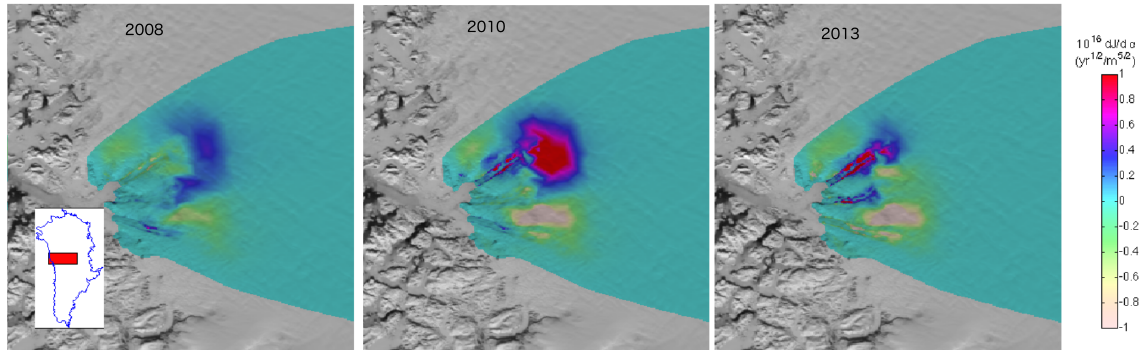
Figure 4. Gradient of the surface velocity cost function (spatio-temporal average of the misfit between a 5-year time series of observed surface velocities and the modeled surface velocity) with respect to the basal drag coefficient (in yr 1 / 2 m − 5 / 2 ). The gradient is computed for every time step of a 2-week interval time series between 2008 and 2013. We only show three periods (2008, 2010, and 2013) in the entire interval. The location for the study is Upernavik Glacier, central West Greenland, and the gradient is taken from an inversion study of the basal forcings required to match observed RADAR time series of surface velocities and calving front